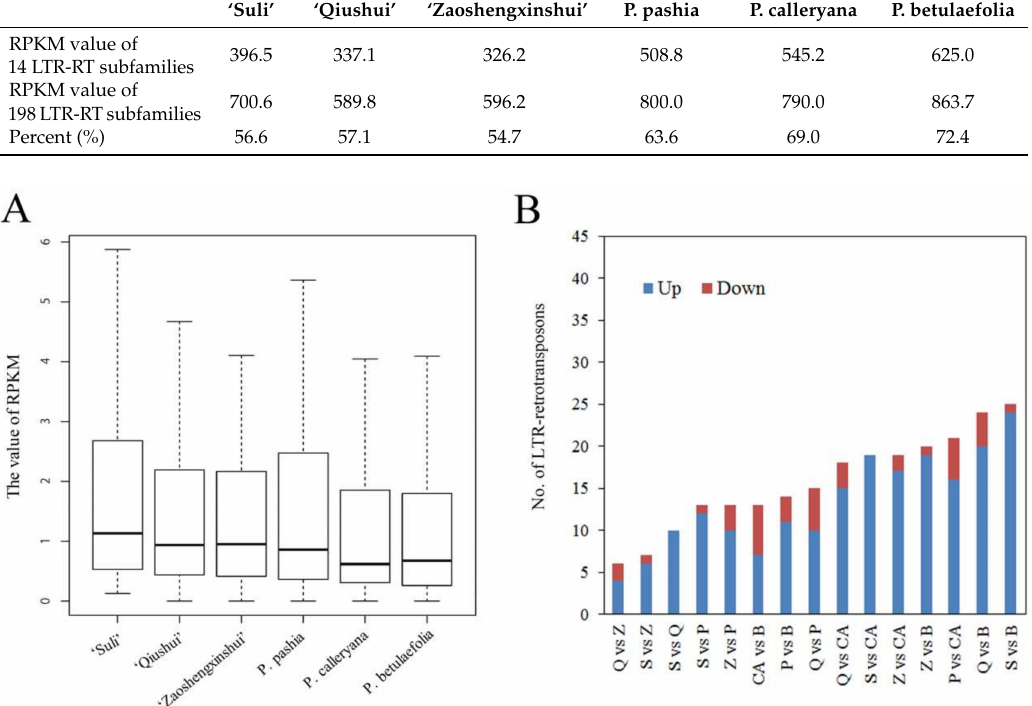
Figure 1. The RPKM values of all 198 LTR-RT subfamilies in Pyrus species. ( A ) Boxplots of all values without outliers. The bottom and top boundaries of each box are the first and third quartiles, and the bold lines within individual boxes are the medians, referred to as the second